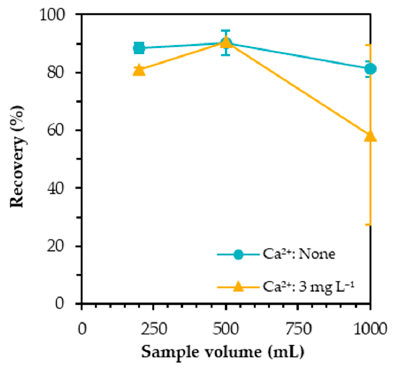
Figure 4. E ff ect of sample volume on recovery of cadmium ions. Experimental conditions: Cd 10 µ g · L − 1 ; AC 50 mg; SDS 100 mg · L − 1 ; sample volume 200 mL; flow rate 1 mL · s − 1 ; eluent 0.1 mol · L − 1 HNO 3 3